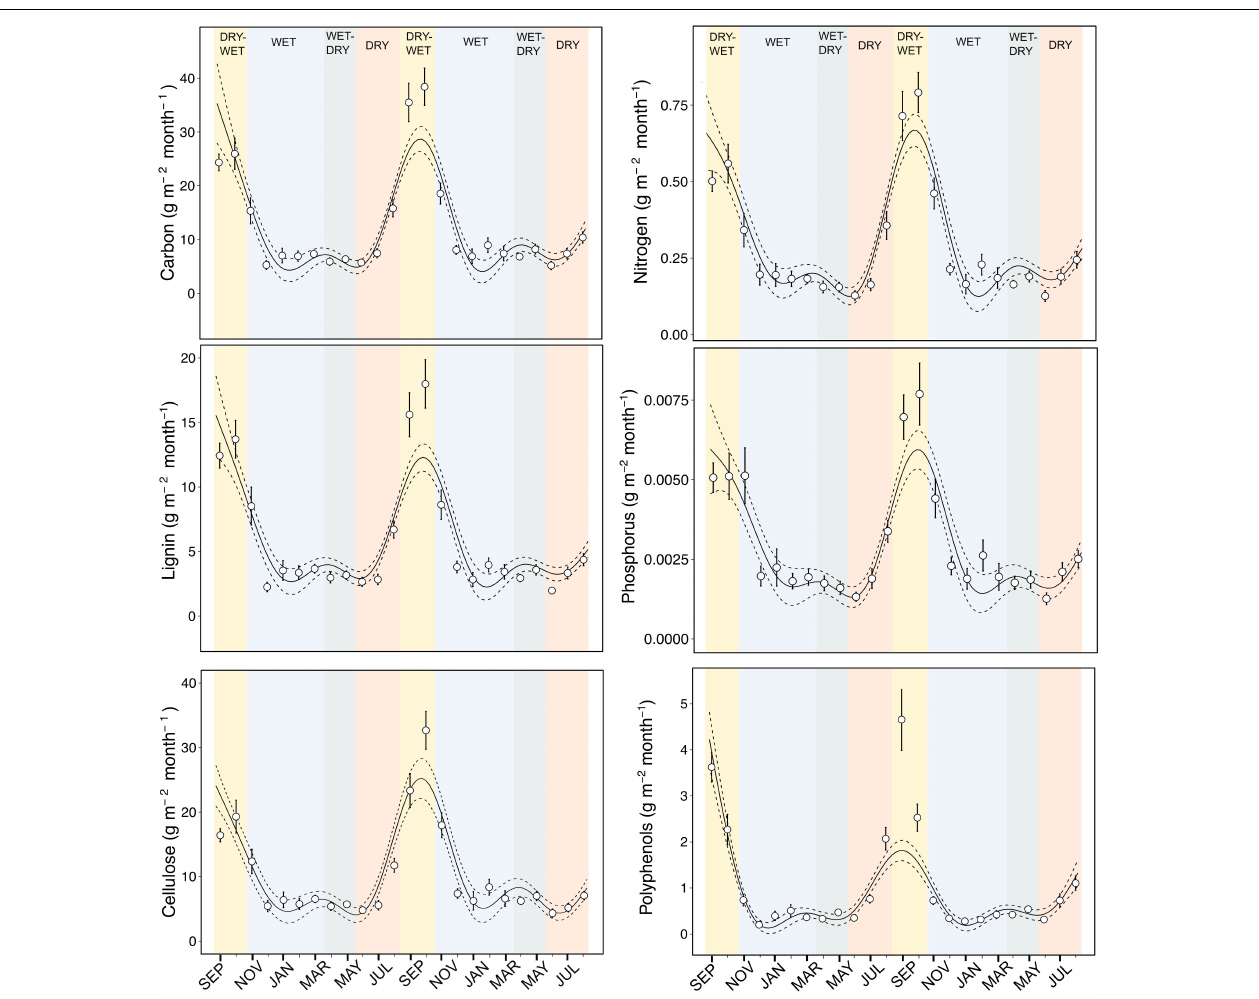
FIGURE 3 | Temporal patterns of litter traits as the mass of each compound (g m - 2 month - 1 ) across the four seasons (dry-wet, wet, wet-dry, and dry seasons) over 2 years. Solid lines represent the non-linear temporal trend from generalized additive mixed models and dashed lines the 95% confidence intervals of the models. Circles are means and vertical lines denote upper and lower limits of standard errors from data of multiple sampling sites within